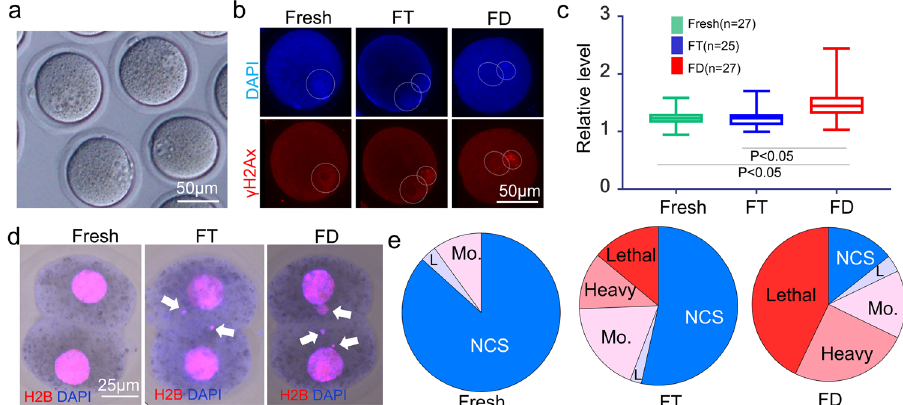
Fig. 4 The foci of gamma-H2AX signals and abnormal chromosome segregation (ACS). a Pseudo-pronuclear formation of cloned one-cell stage embryos derived from FD somatic cell nucleus. See Table 1, “ No. of PN formed oocytes ” . b Immunostaining of zygotes derived from fresh control, FT somatic, and FD somatic cells using anti-gamma-H2AX antibodies. Nuclei are stained with 4 ’ ,6-diamidino-2-phenylindole (DAPI; top, blue). The foci of gamma-H2AX signals show DNA double-strand breaks (bottom, red). c Plot of brightness of each pseudo-pronucleus. n = 25 – 27 1-cell embryos examined three independent experiments. See Supplementary Table 3 for more details. Data are presented as mean value, minima and maxima. P < 0.05 (one-way ANOVA and Tukey-multiple comparison-test). d Detection of abnormal chromosome segregation (ACS) of cloned embryos derived from fresh, FT, and FD somatic cell nuclei. Arrows are judged as micronuclei using merged images. e Ratio of normal chromosome segregation (NCS: blue) and ACS (L: light; Mo: moderate; heavy and lethal) of cloned embryos derived from fresh, FT, and FD somatic cell nuclei.